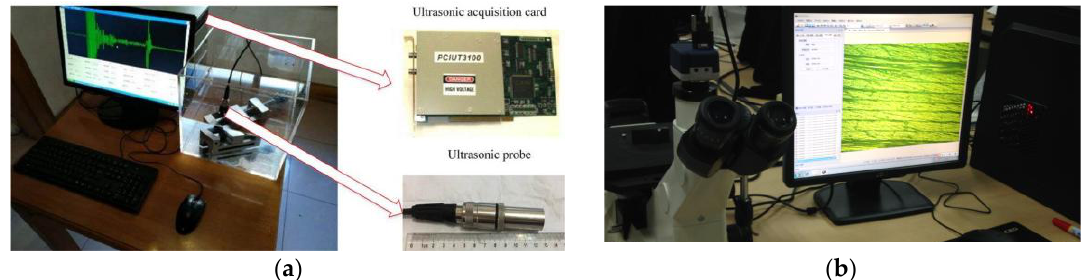
Figure 7. Experimental system. ( a ) Ultrasonic test system; ( b ) metallographic microscope system.